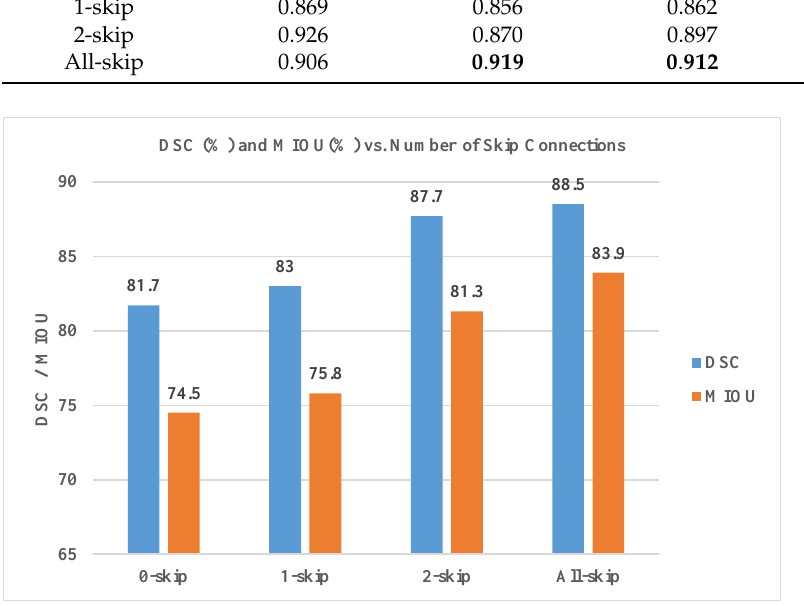
Figure 10. The influence of different number of skips on DSC and